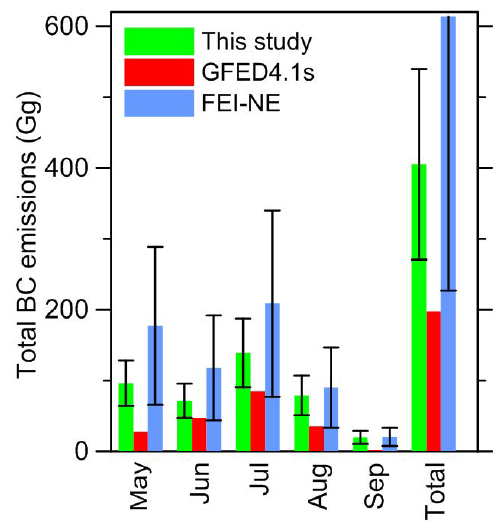
Figure 12. BC amounts (in Gg) emitted from fires in the study re- gion in the period from May to September 2012: the estimates con- strained by satellite AAOD and AOD satellite observations are pre- sented in comparison to corresponding estimates calculated using the GFED4.1s and FEI-NE data. The error bar in the positive direc- tion for the FEI-NE estimate is not shown to improve the readability of the